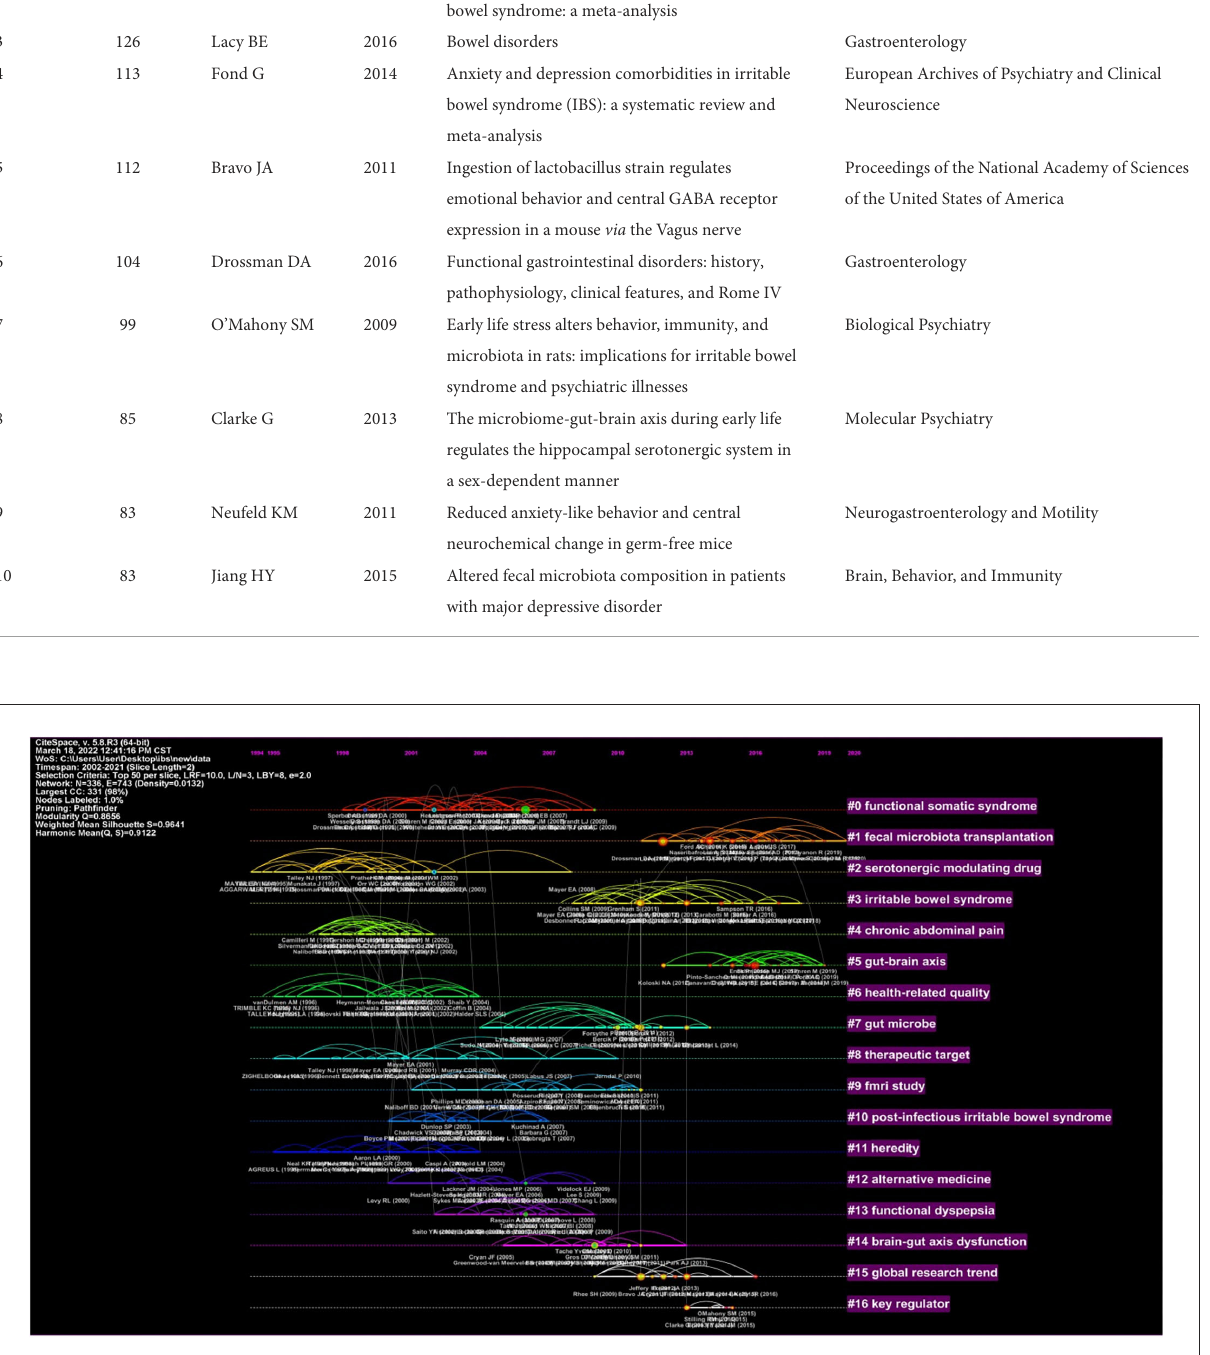
FIGURE6 Timeline view for references co-citation